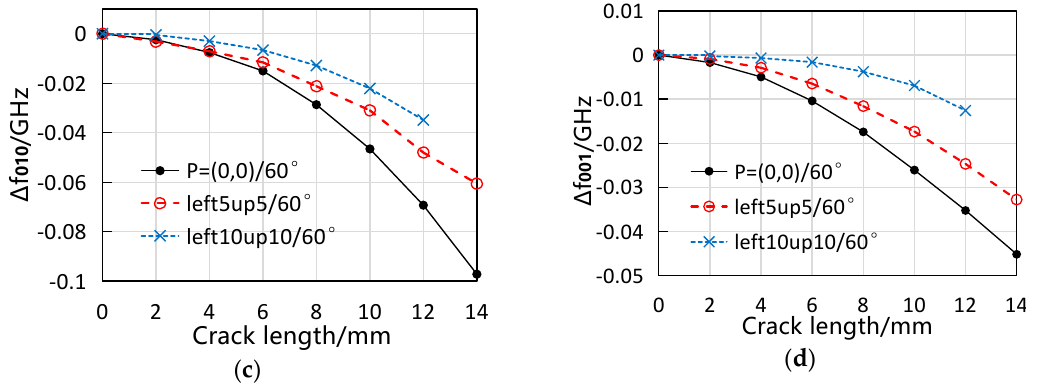
Figure 13. Measured resonant frequency response with the crack moving to P = ( 5,5 ) and P = ( 10,10 ) . ( a ) f 010 and ( b ) f 001 response at 30 ◦ direction; ( c ) f 010 and ( d ) f 001 response at 60 ◦